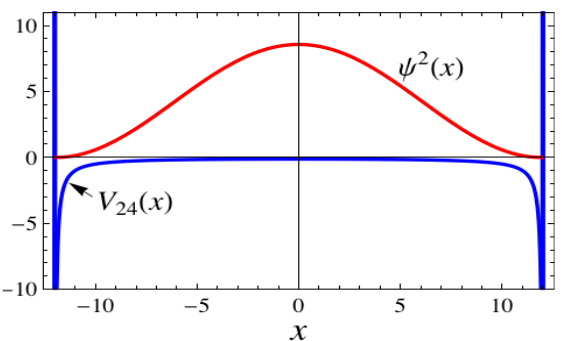
( x ) blue with E 24